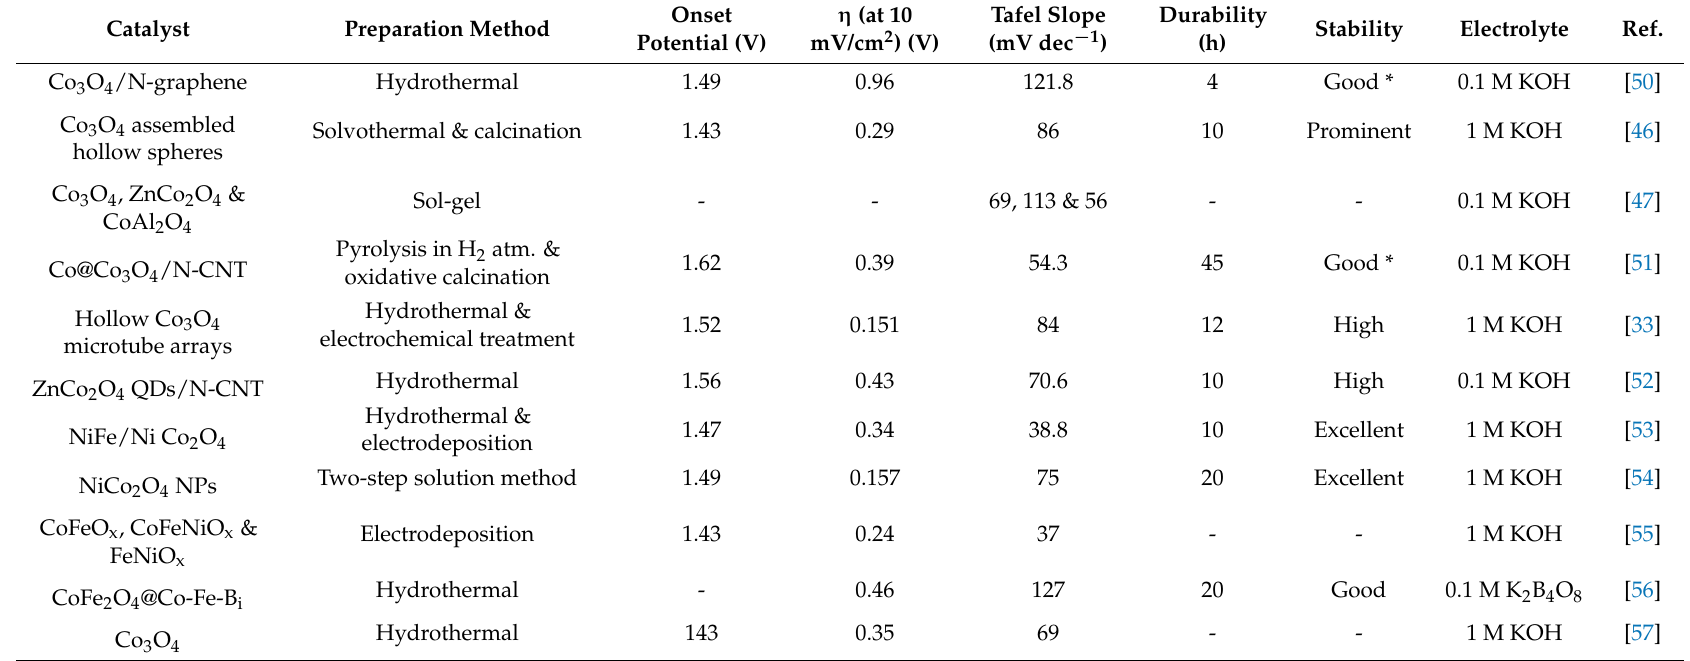
Table 3. Comparison of the electrocatalytic activity of spinel catalysts (cf. Table 1 for definitions of “durability” and